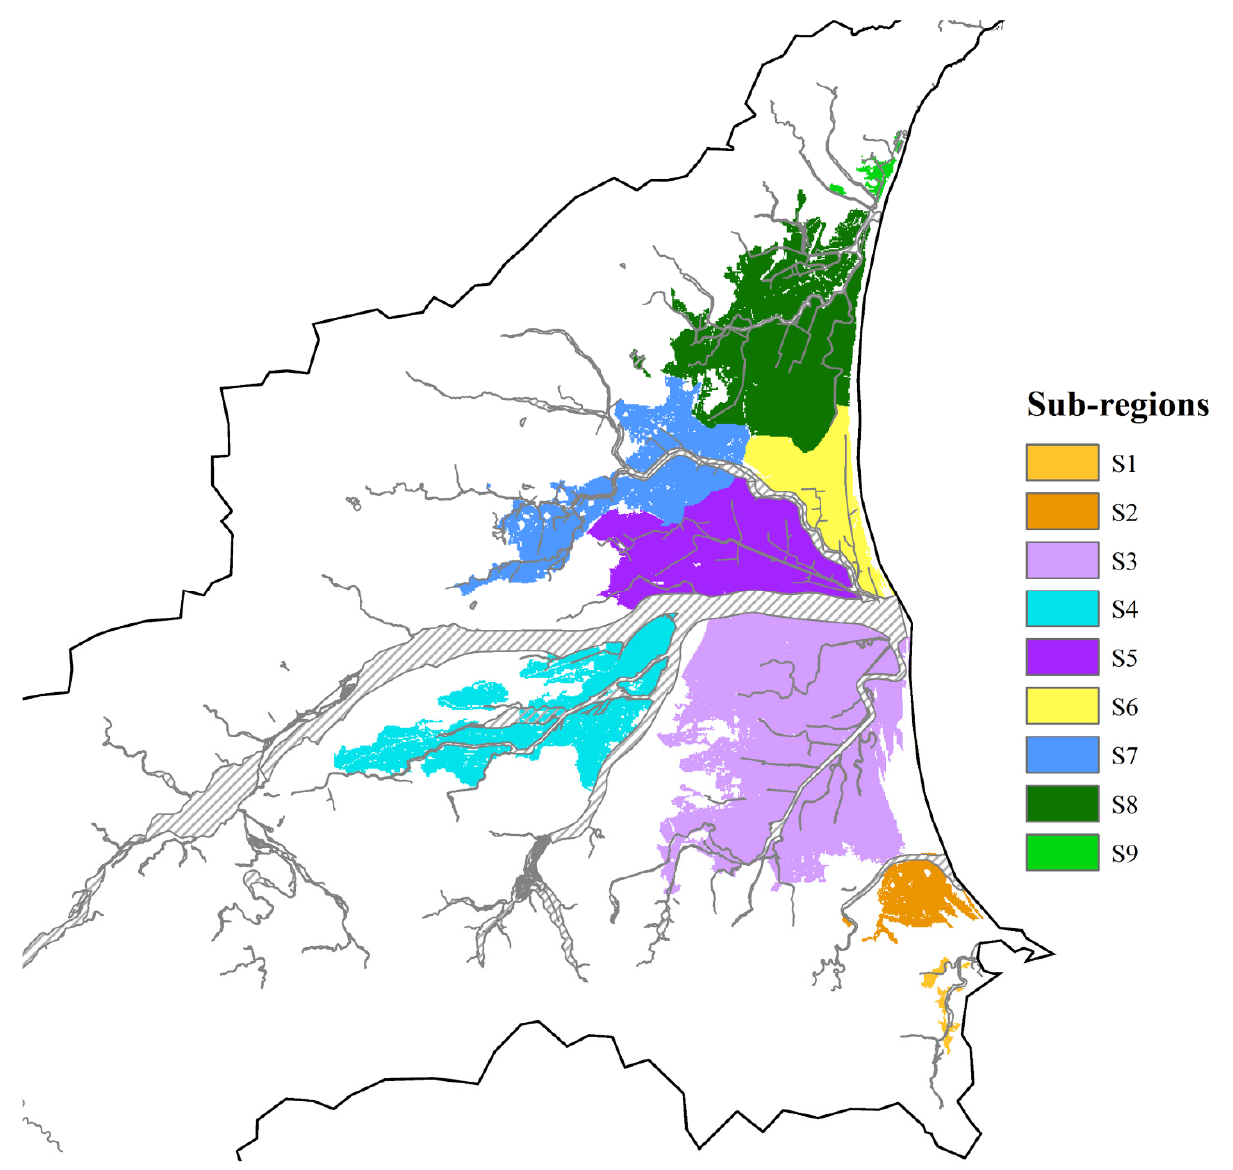
Figure 5. Nine sub-regions in Yilan County divided by flooding characteristics.